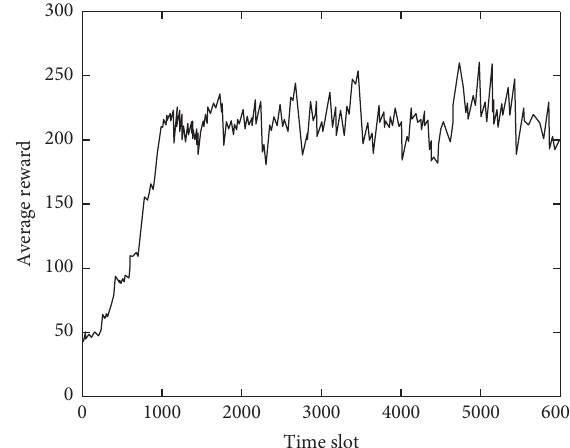
Figure 2: The average reward in the training process of the proposed algorithm.